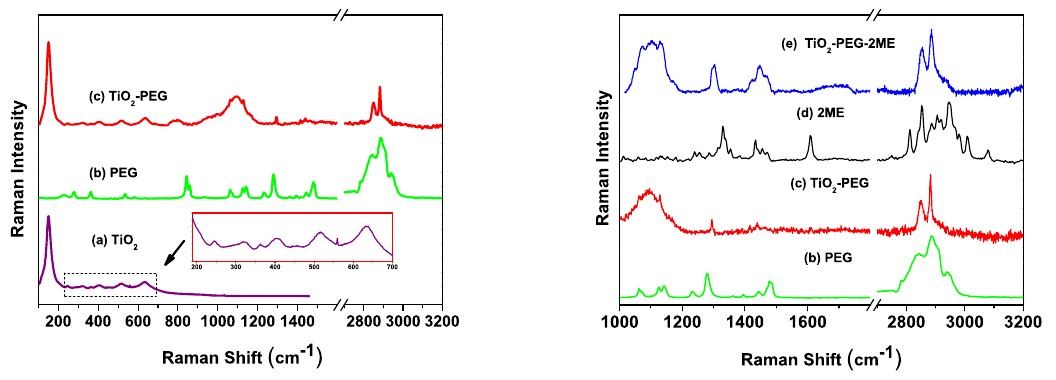
Figure 4. The left and right side graphs show the Raman spectra for ( a ) TiO 2 ; ( b ) PEG, and ( c ) TiO 2 –PEG, recorded in the zone 150–3200 cm − 1 ; ( d ) 2ME; and ( e ) TiO 2 –PEG–2ME in the region 1000–3200 cm − 1 ,